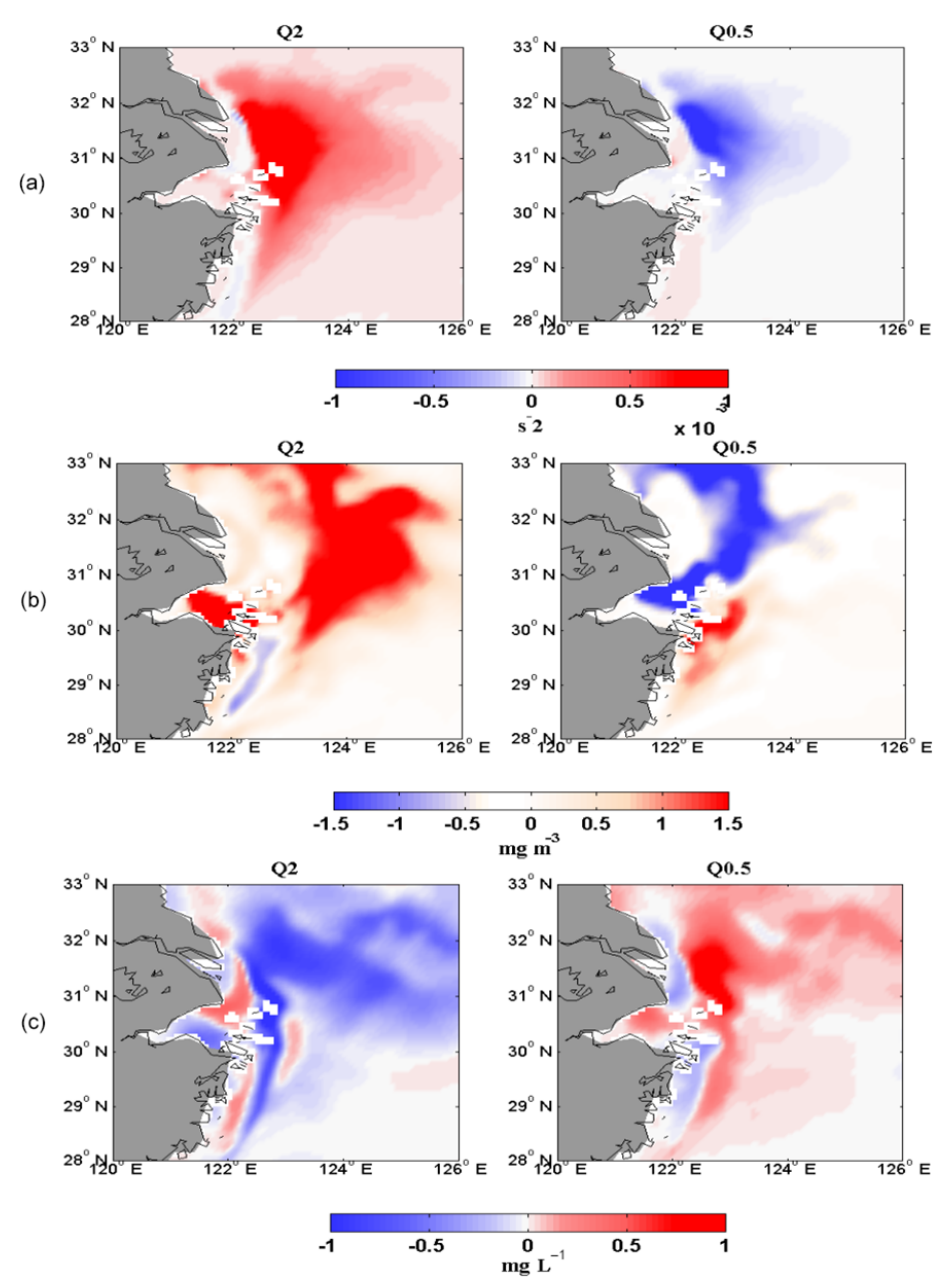
Figure 11. (a) The deviation in summer (7–9 months) stratification ( N 2 ) of Q 2 and Q 0 . 5 from the base run. (b) The deviation in summer (7–9 months) chlorophyll concentration of Q 2 and Q 0 . 5 from the base run. (c) The deviation in summer (7–9 months) bottom dissolved oxygen concentration of Q 2 and Q 0 . 5 from the base